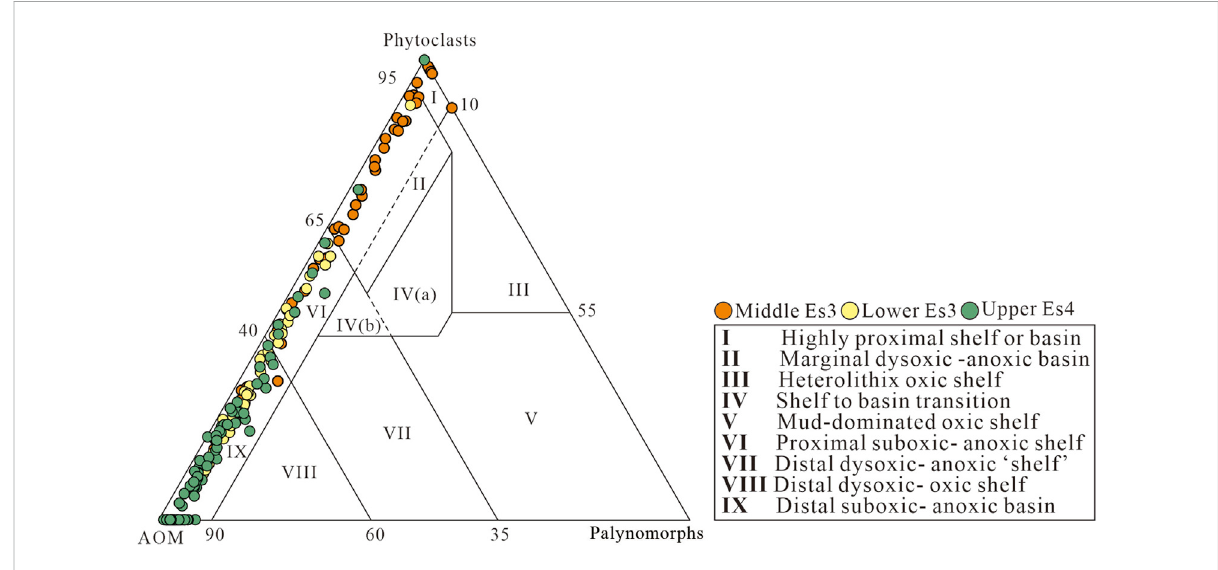
FIGURE 7 The ‘ A-P-P ’ ternary plots for the Shahejie Formation of Dongying Sag.